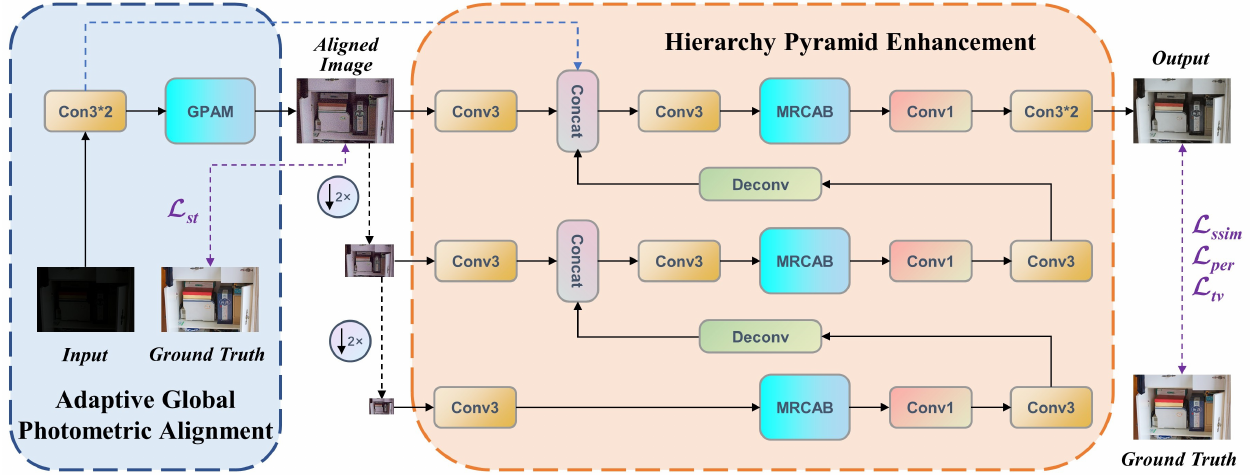
Figure 2. An illustration of the proposed CFANet. It contains an adaptive global photometric align- ment sub-network for style transformation, and a hierarchy pyramid enhancement sub-network for optimization of the image quality. We build the GPAM with the basic U-net structure. The proposed MRCABs are inserted in hierarchy pyramid architecture to extract multi-scale features in a wider range, suppressing artifacts and color distortion more efficiently. The low-light images are mapped to the output in a coarse-to-fine